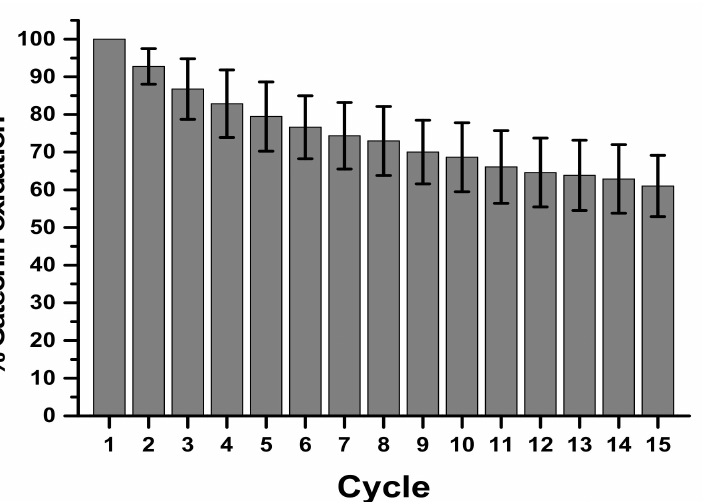
Figure 5. Reuse of CP-50ME after 15 successive cycles in the determination of catechin at 30 µ M in sodium acetate buffer pH 5.0 after 2 min of enzymatic reaction. The average provided corresponds to three